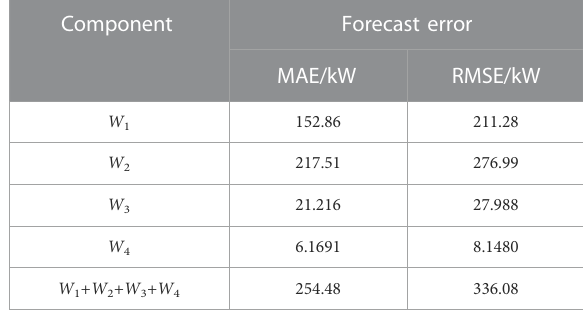
TABLE 3 Forecasting results of